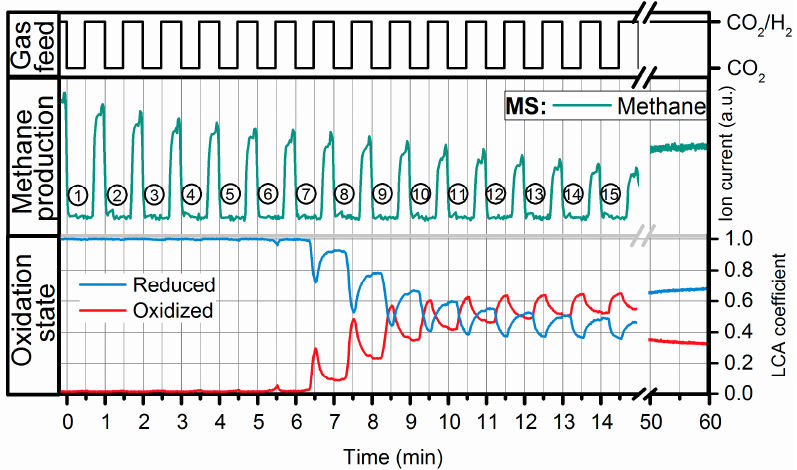
Figure 3. Methanation of CO 2 during dynamic operation, switching every 30 s between methanation conditions (H 2 /CO 2 = 4) and CO 2 at constant WHSV of 12,000 mL CO2 /(g cat ·h) and GHSV of 71,700 h − 1 .